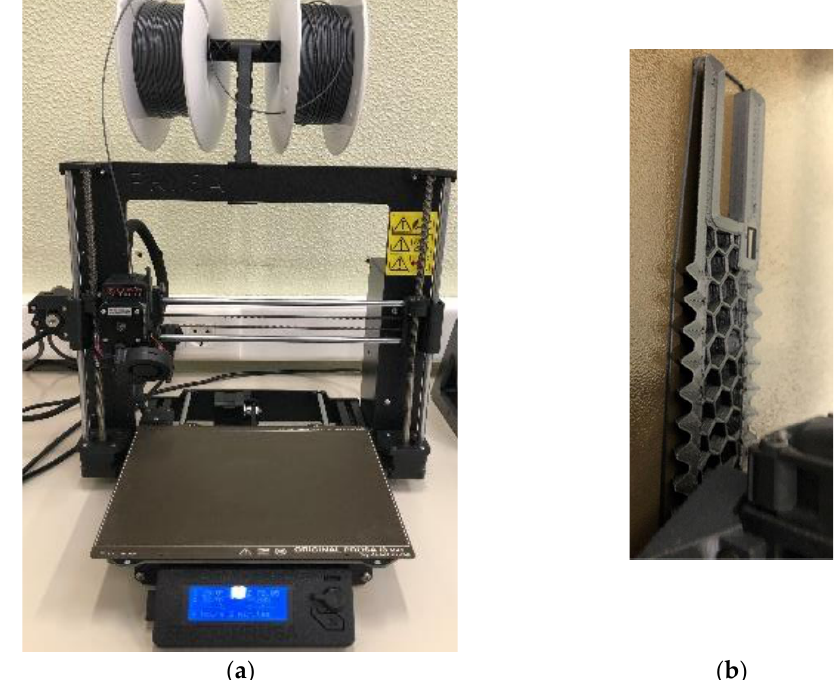
Figure 6. ( a ) Prusa i3 mk3s+ equipment; ( b ) Example of a printing detail.